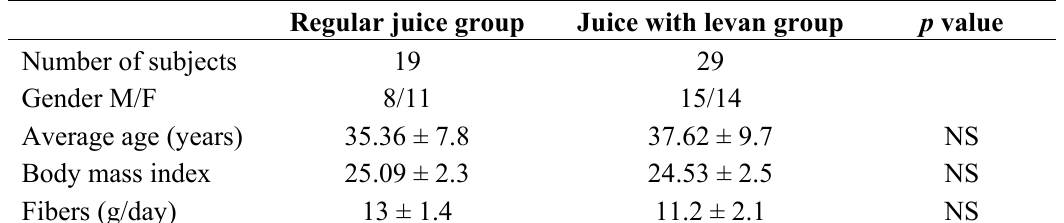
Table 2. Demographics of the study